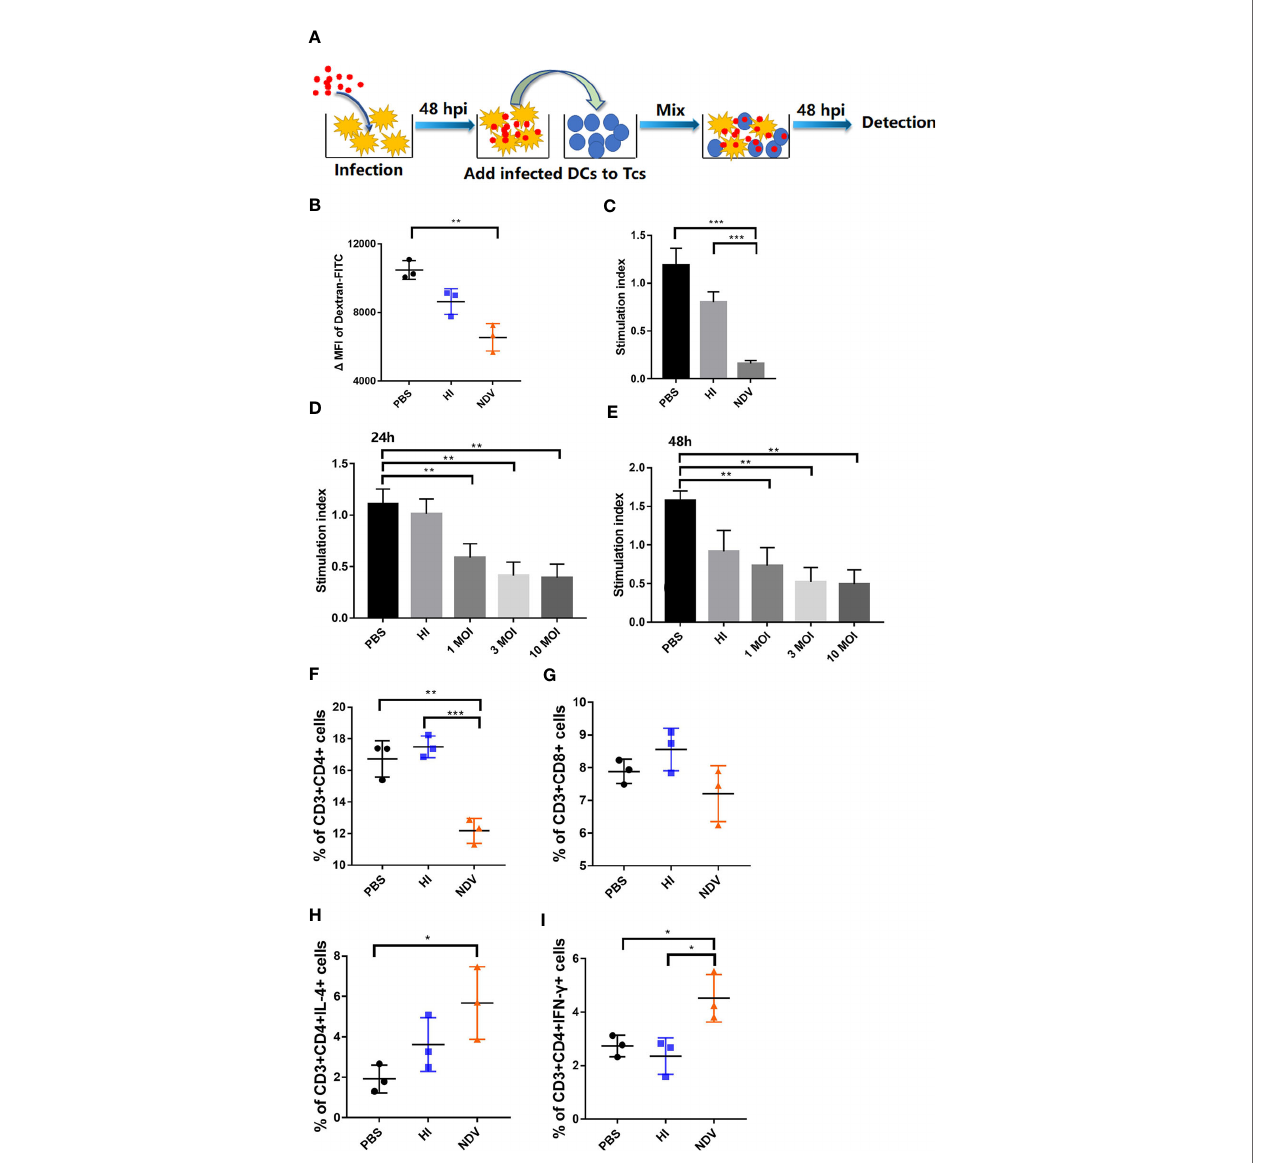
FIGURE 2 | Antigen uptake and presentation of infected DCs. Schematic representation of DC/T-cell co-cultures (A) . Treated DCs were incubated with FITC- Dextran at 37°C or 4°C (negative control) respectively and the antigen capture were analyzed by fl ow cytometry as mean fl uorescence intensity value (B) . Proliferation of T cells in co-cultures was measured using MLR assay (C) . DCs were infected with NDV at 0.1, 1, 10 MOI and co-cultured with T cells. Proliferation of T cells in co-cultures were measured at 24 h (D) or 48 h (E) . Proportions of CD3 + CD4 + T cells (F) and CD3 + CD8 + T cells (G) in co-cultures were evaluated by fl ow cytometry. CD3 + CD4 + T cells secreting IL-4 (H) or IFN- g (I) in co-cultures were evaluated by fl ow cytometry. All experiments were performed independently at least thrice and results were presented as means ± standard deviation. Signi fi cance levels were de fi ned as *p < 0.05, **p < 0.01 and ***p <